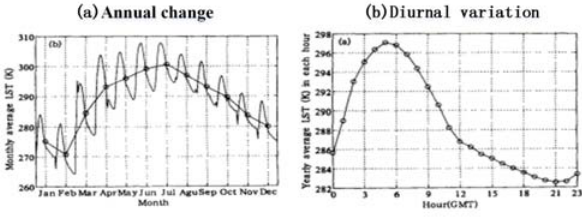
Figure 1. Change of clear sky LST in 2000, in East Asia Figure 1(b) shows that, with the impact of solar radiation, the gradient of surface temperature change during daytime is much larger than that at night. For the region of East Asia, surface